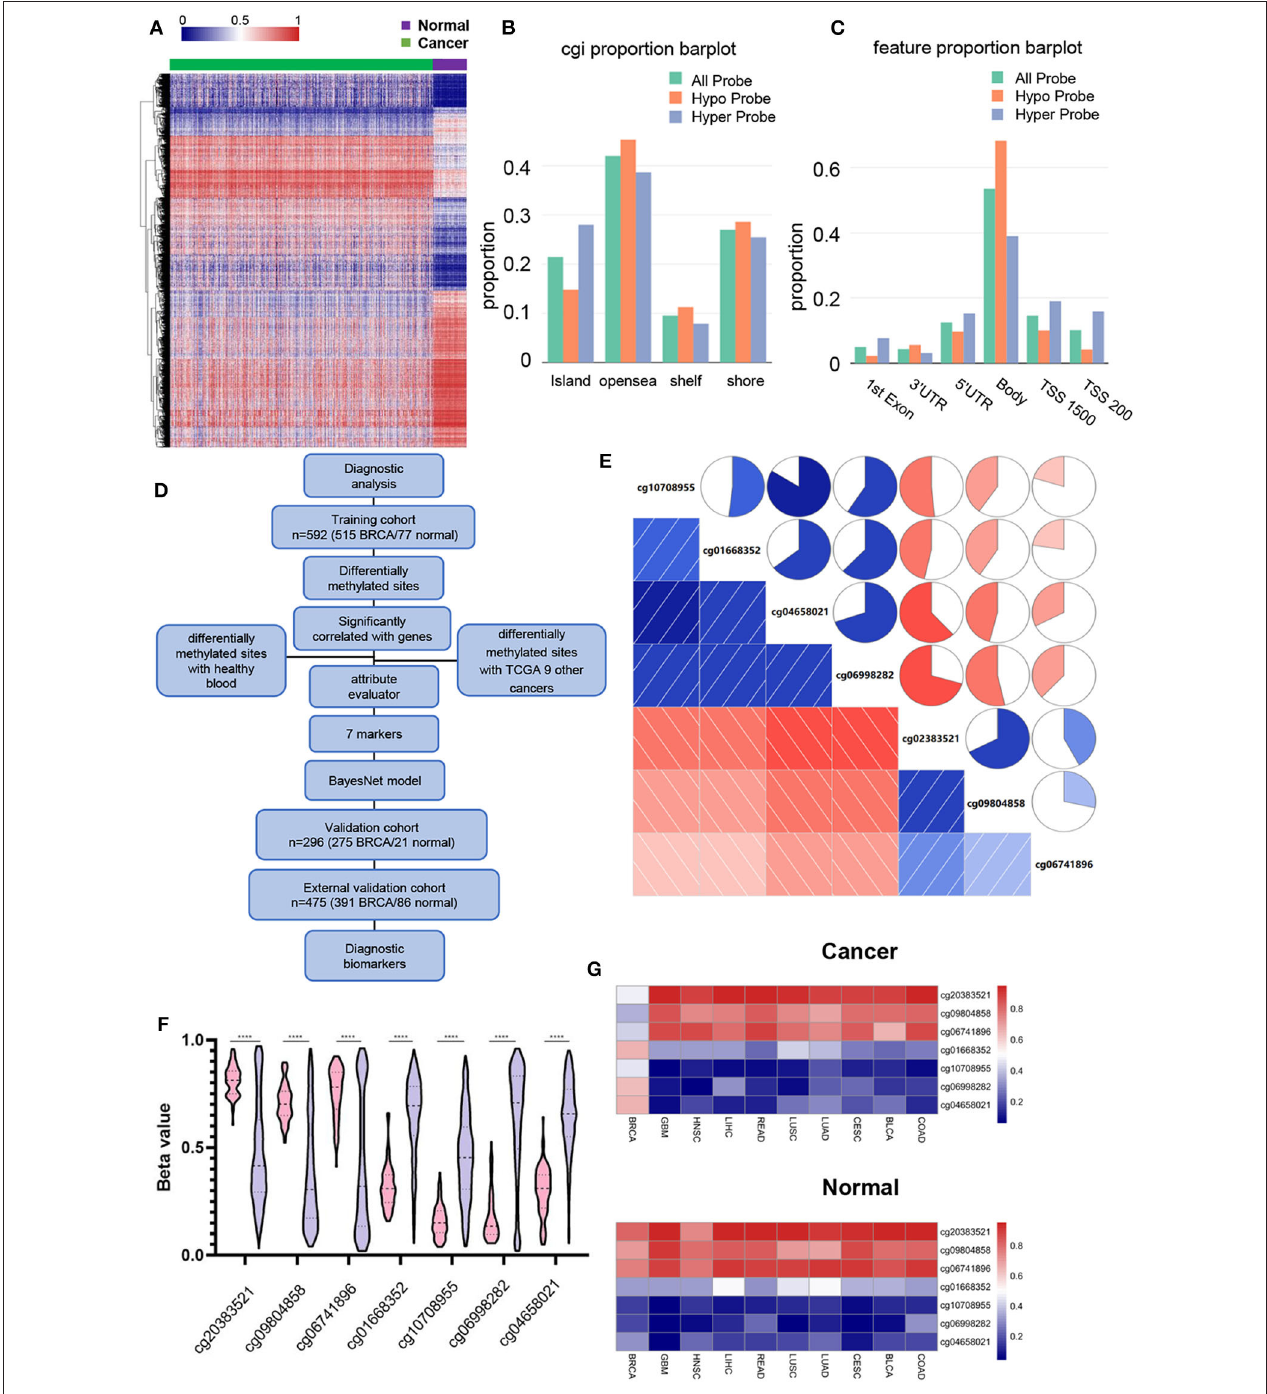
FIGURE 1 | Identifying BRCA-specific differentially methylated sites. (A) Heatmap of the differentially methylated sites, contains 2,362 hypermethylated and 2,322 Hypomethylated DMSs. Green are cancer tissues and purple are normal tissues. (B) Differential methylation sites distribution in CpG island, opensea, shelf, and shore. The DNA methylation sites between genes have been omitted. (C) Differentially methylated the distribution of DMS based on the distance to the TSS. (D) Flowchart for finding BRCA candidate diagnostic biomarkers. (E) Correlation between 7 DMSs. The square and circle symbols represent the one-to-one correlation coefficient. Blue indicated the positive correlation, and red indicated the negative correlation. Each correlation coefficient was shown by the shadow intensity and increased uniformly as the correlation value starts from 0 to 1. (F) Methylation level of 7 DMSs in BRCA and normal tissues. Pink represents normal tissue, purple represents BRCA tissue. (G) The sites mean β value show the methylation levels of 7 BRCA markers in BRCA and nine other cancers.